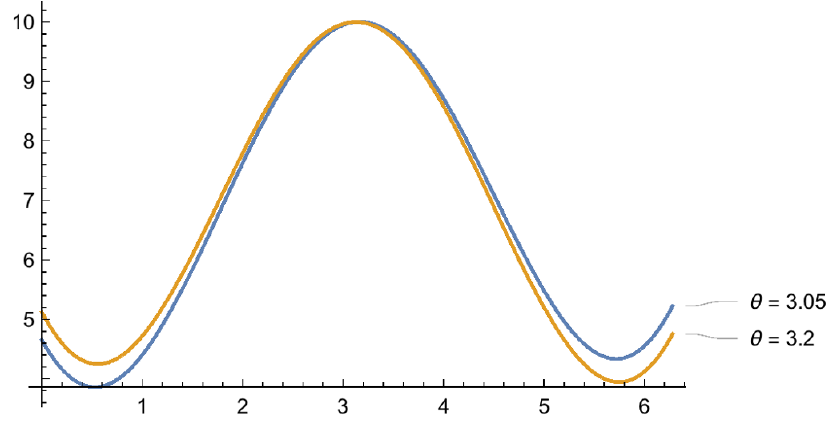
Figure 3 . V ( (cid:30) ) for two values of (cid:18) on opposite sides of (cid:25) and (cid:15) = 5. The true minimum swaps abruptly as one goes through (cid:18) = (cid:25) . For the apparent lack of 2 (cid:25) periodicity in this (cid:12)gure see the discussion in the